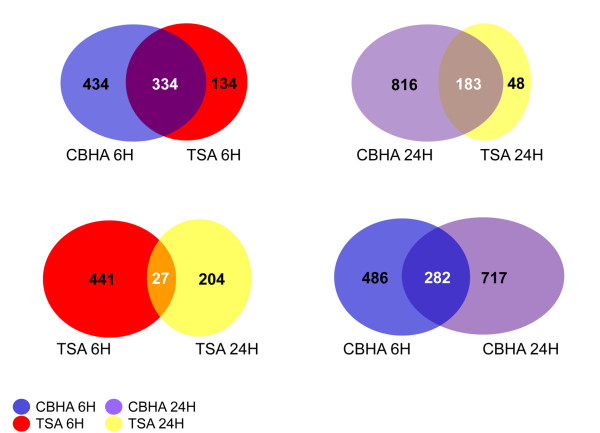
Venn diagrams show the number of differentially expressed probe sets elicited in response to CBHA or TSA treatment of cardiac myocytes for 6 or 24 h. The number of genes affected by CBHA is almost twice that elicited by TSA. There is lesser overlap among the DEGs elicited early (6 h) and late (24 h) for both TSA and CBHA compared with a much larger number of common transcripts induced by TSA and CBHA at either time point.